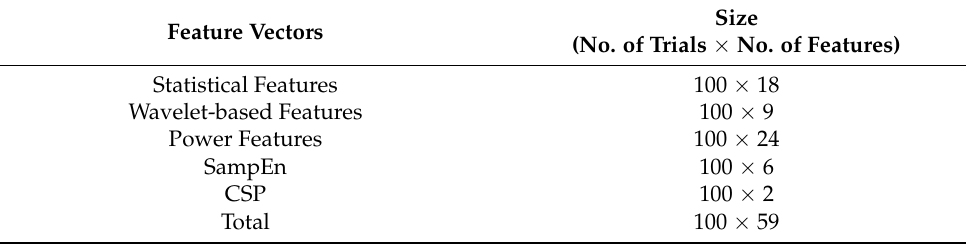
Table 2. Feature vectors classifying left versus right